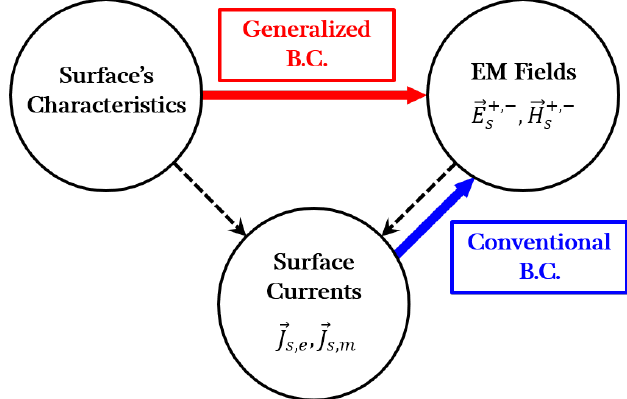
Figure 2. Conventional boundary conditions and generalized boundary conditions.